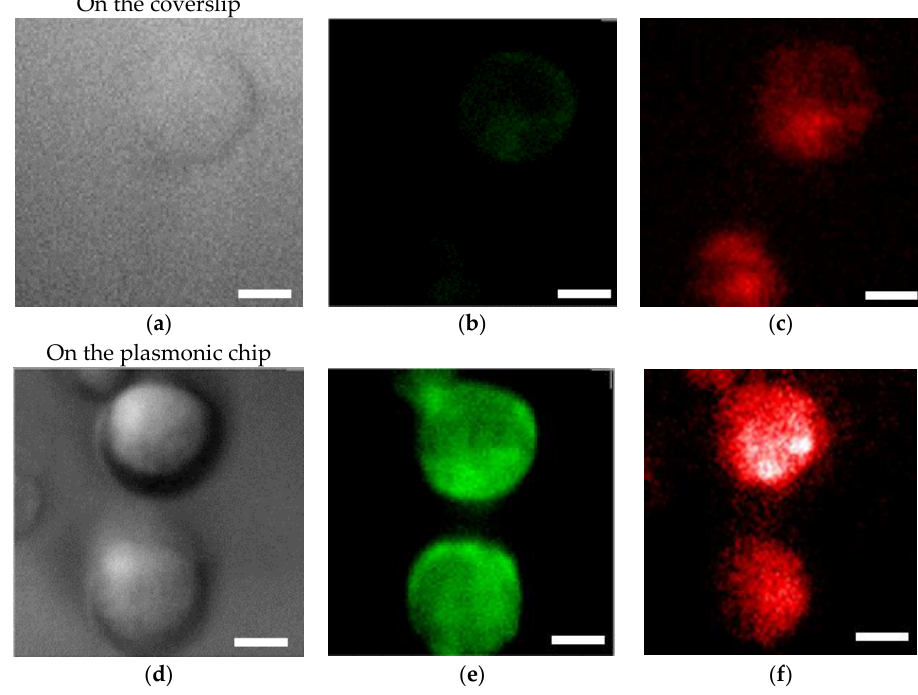
Figure 5. Bright field images ( a , d ), Alexa ® 488-EGFR fluorescence images ( b , e ), and APC-EpCAM images ( c , f ) for MDA-MB-231 cells. The upper panels ( a – c ) and the lower panels ( d – f ) show the images taken on the coverslip and plasmonic chip, respectively. The max-min intensities that express the brightness contrast in fluorescence images of Alexa ® 488-EGFR and APC-EpCAM were adjusted to lie within the range of 3400 and 1200 counts /s, respectively. Bars correspond to 10 μm. Table 1. Enhancement factor of Alexa ® 488-EGFR and APC-EpCAM.